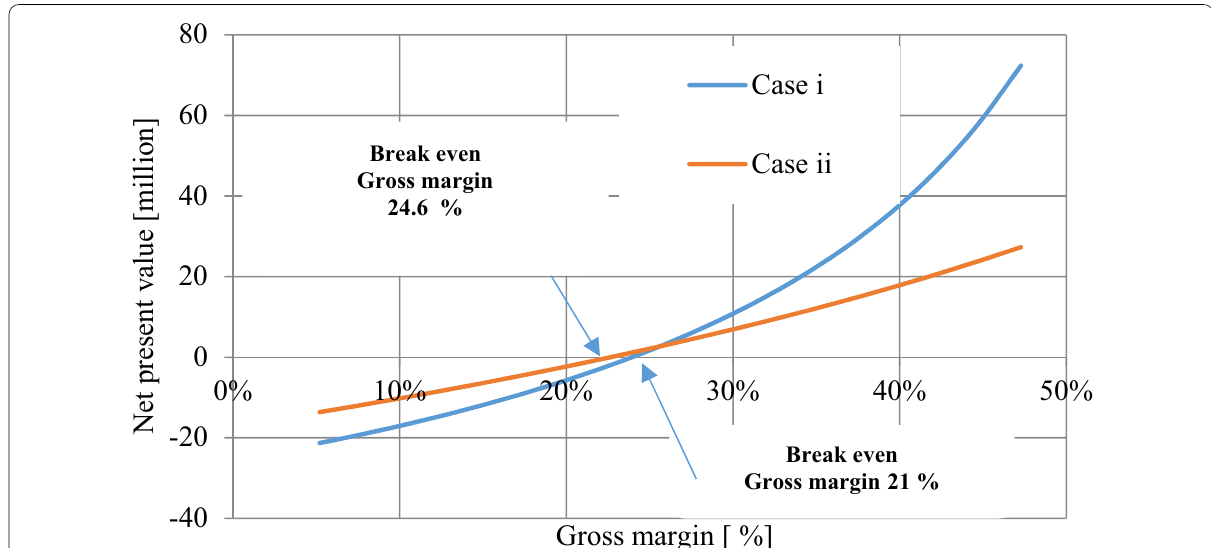
Fig. 13 Illustration of breakeven sensitivity analysis for two different debt-to-equity capital structure